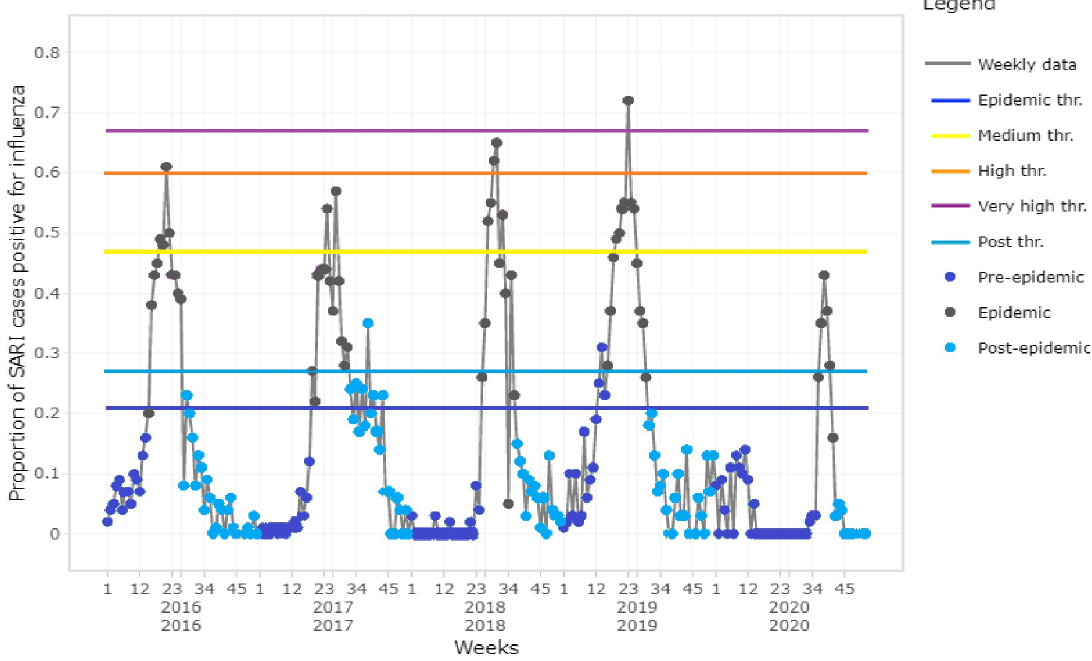
Fig 2. Time series of influenza epidemic, the epidemic periods modelled by MEM for season 2016–2020 in